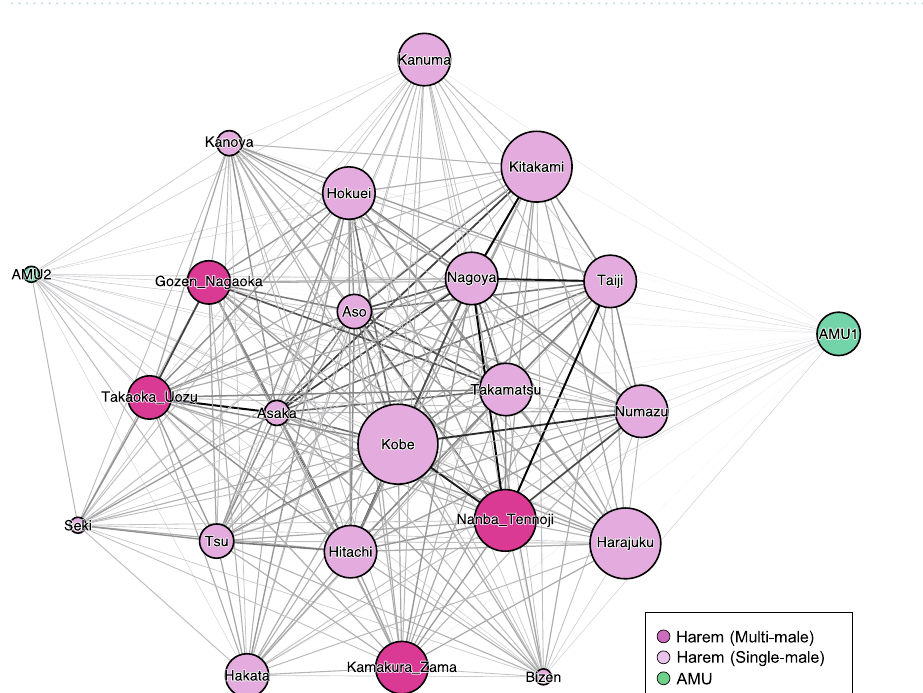
Figure 5. The social network based on the association matrix. The edge thickness represents the value of the simple ratio index. It was created with ForceAtlas algorithm under Gephi0.92 environment 63 . Nodes represent units, where the pink one represents a multi-male harem, the light pink represents a single-male harem, and the green represents an AMU. The names of the harems were based on the names of the adult